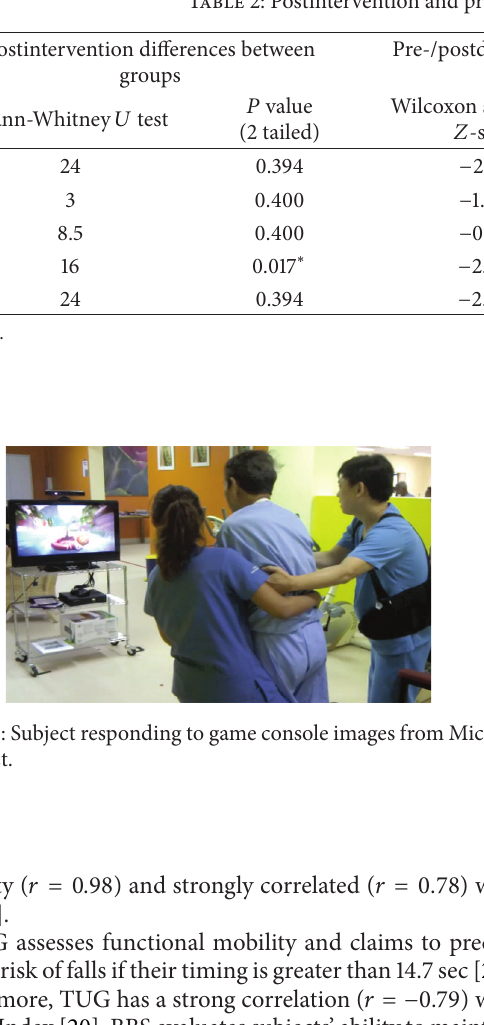
Table 2: Postintervention and pre-/postdifferences between and within groups.